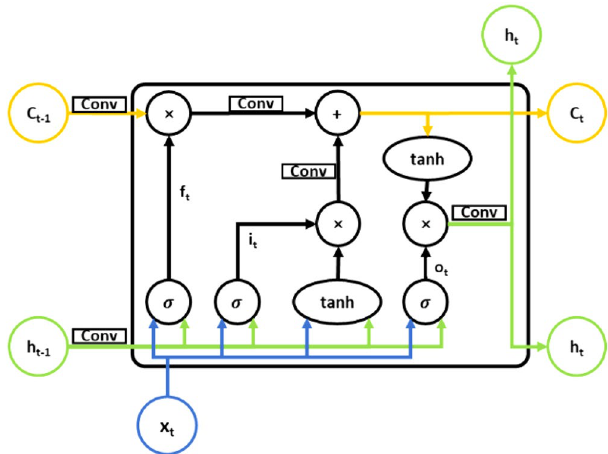
Figure 4. Networks of Conv LSTM